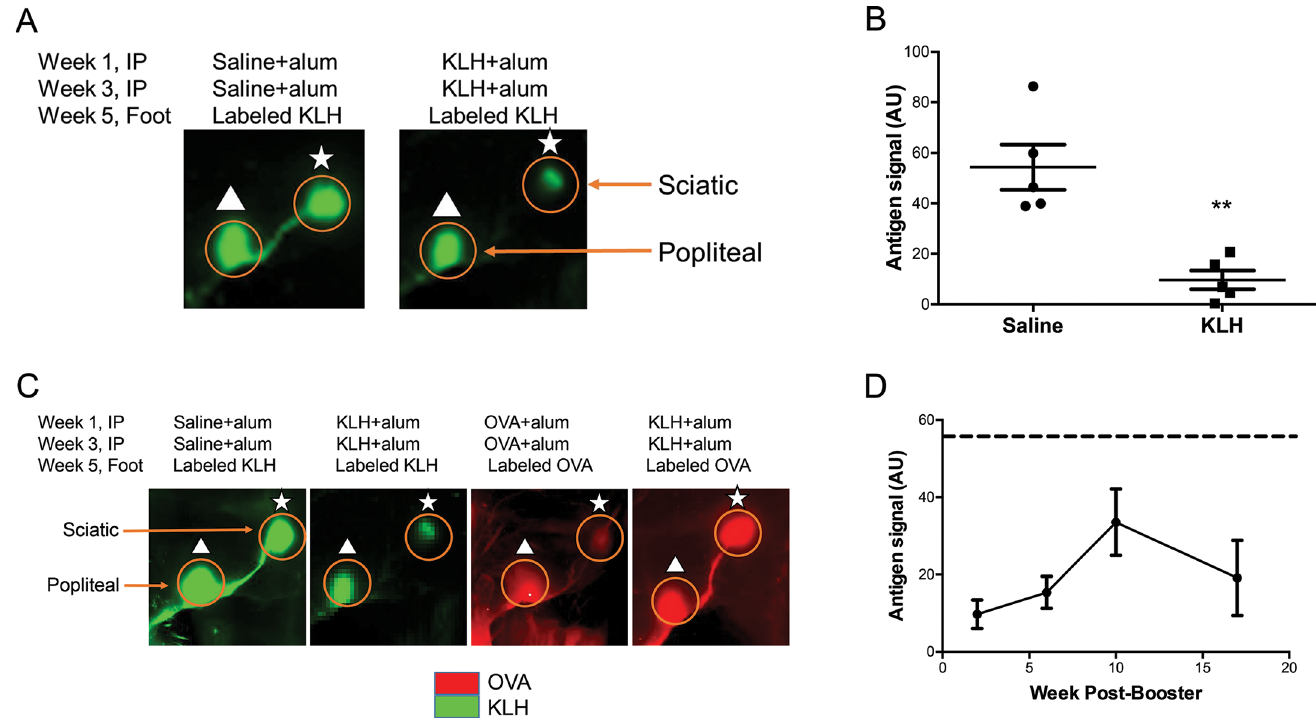
Figure 2. Antigen flow is restricted in immunized mice upon re-exposure to that antigen. (A, B) Mice were immunized twice with intraper- itoneal injections of KLH and alum or saline and alum. Two weeks after the second injection, 200 μ g of KLH-800CW was injected subcu- taneously into the dorsum of the hind paw. (A) A lesser antigen signal was observed in the sciatic lymph nodes of KLH-immunized mice as compared with naïve mice. Images are representative; triangles indicate popliteal lymph nodes and stars represent sciatic lymph nodes. (B) Data shown are individual values (naïve, 54.34 ± 8.840, n = 5 versus KLH-immunized, 9.730 ± 3.715, n = 5, p < .001 by t test). (C) This effect was specific to the immunized antigen, as OVA signal injected in a mouse immunized to KLH was not reduced, but OVA injected into OVA-immunized mice was reduced. Images are representative of five animals per group. (D) Antigen signal in the sciatic lymph node remained less in mice injected in the foot for at least 17 wks after booster injection. Antigen signal from the sciatic lymph node in animals immunized with KLH-800CW was determined at various time points following booster injection with KLH. The hashed line at the top of the figure represents the mean antigen signal detected in sciatic lymph nodes of saline-immunized control animals, as dis- played in Figure 2B. Data represent mean ± SEM. Dotted line indicates average naïve mouse antigen signal. n = 5 to